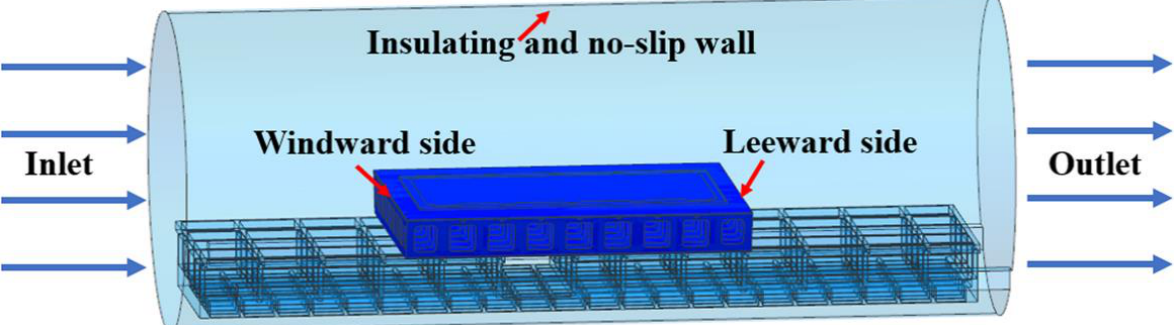
Figure 7. Boundary conditions.